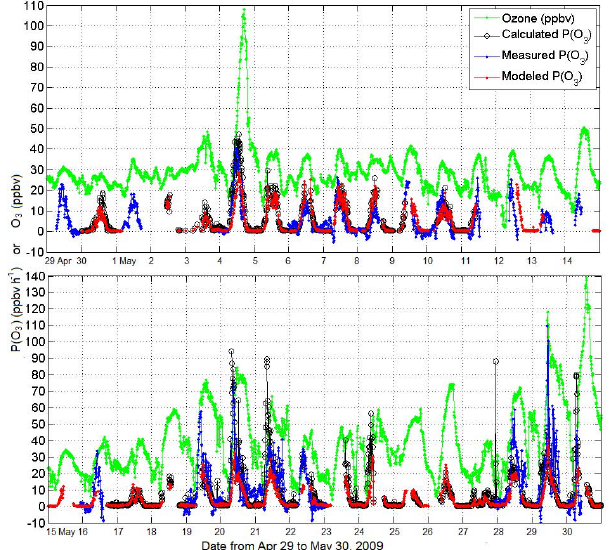
Fig. 1. Time series from 29 April to 30 May 2009 for ambient ozone (green dots), calculated P (O 3 ) from measured radicals (black circles), measured P (O 3 ) with the MOPS (blue dots) and modeled P (O 3 ) from the RACM2 mechanism (red